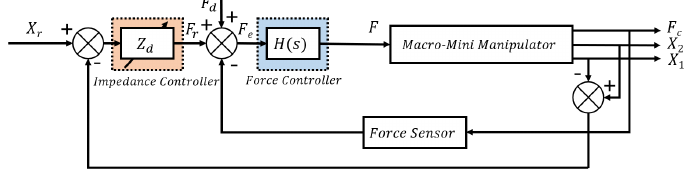
Figure 15. Block diagram of impedance